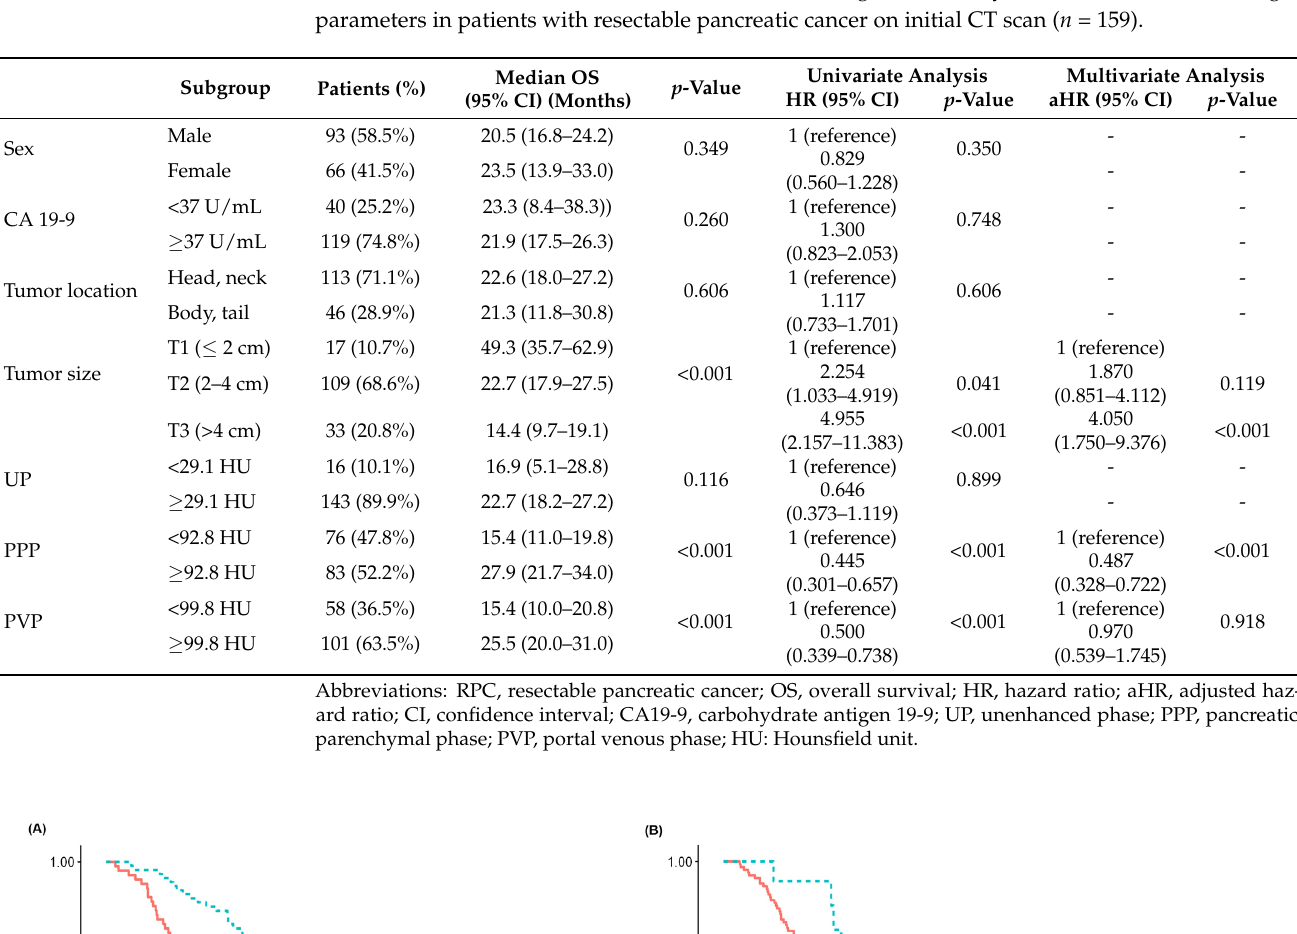
Table 4. Univariate and multivariate Cox hazard regression analysis of clinical and radiologic pa- rameters in patients with borderline resectable or locally advanced pancreatic cancer on initial CT scan ( n = 139). Subgroup Patients (%)